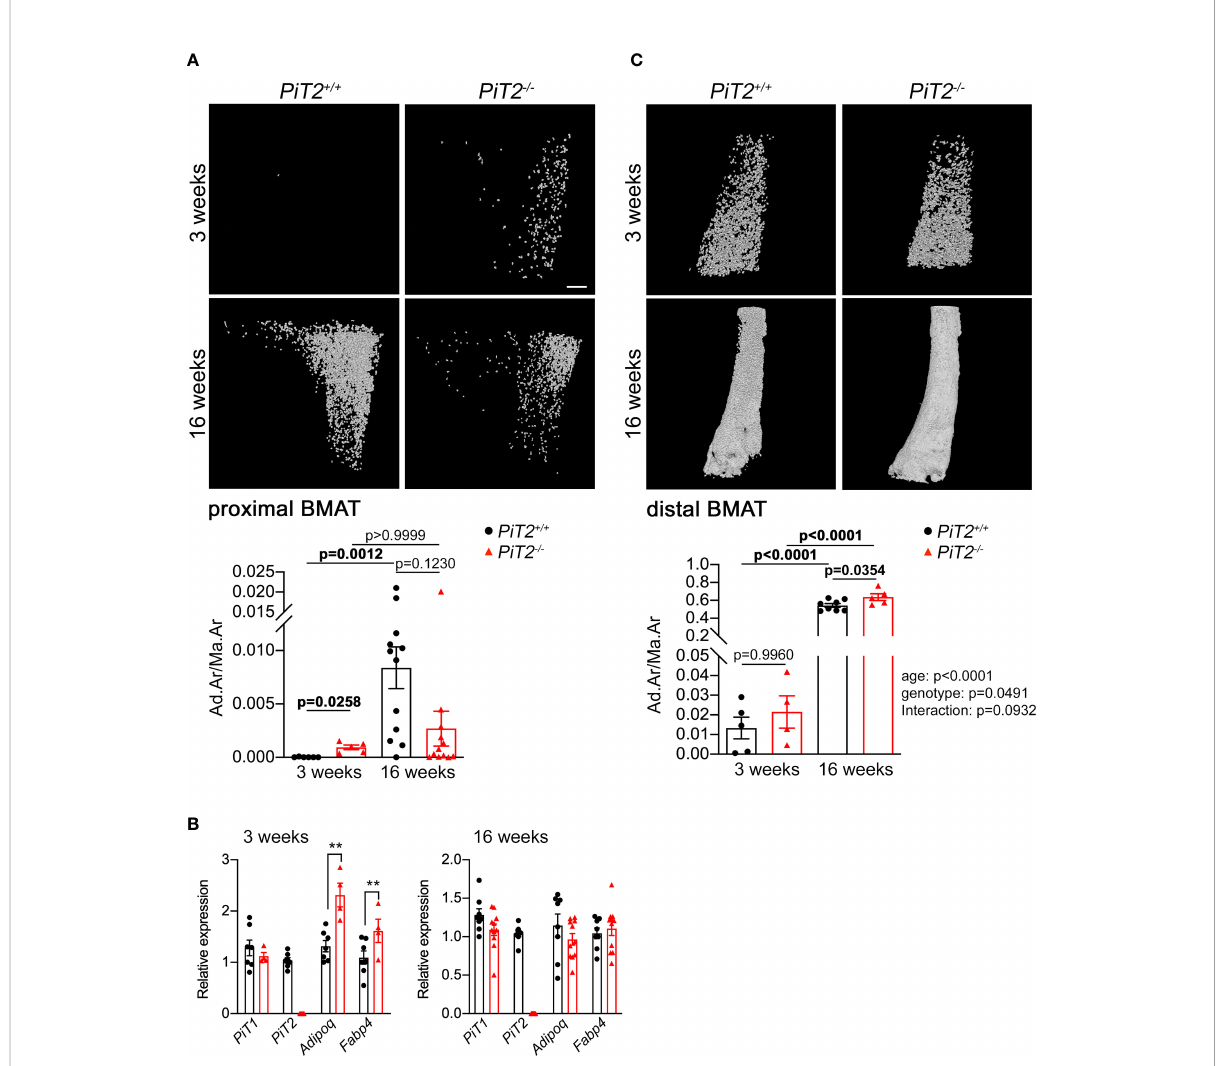
FIGURE 1 Deregulation of BMAT volume in PiT2 -/- female mice. (A) Upper - Representative 3D visualization, using Hf-POM-based CE-CT, of the adipocytes in the bone marrow compartment of the proximal tibia of 3- and 16-week-old PiT2 +/+ and PiT2 -/- female mice. Scale bar = 250 m m. Lower - Graphs showing quanti fi cation of the volume fraction of the adipocytes in the VOI of the proximal tibia (Ad.Ar/Ma.Ar: Adipocyte area/Marrow Area) of 3- and 16-week-old PiT2 +/+ and PiT2 -/- mice (n=6 and 12 per genotype, respectively). Data are means ± SEM, Bonferroni-corrected Mann-Whitney test. p values are indicated. (B) Relative PiT1 , PiT2 , Adiponectin and FABP4 mRNA expression in the whole tibia from 3- (n=7 PiT2 +/+ and n=4-6 PiT2 -/- ) and 16- (n=8 PiT2 +/+ and n=11 PiT2 -/- ) week-old PiT2 +/+ and PiT2 -/- female mice, as indicated. Data are means ± SEM, Mann-Whitney test, ** p<0.01 . (C) Upper - Representative 3D visualization of the adipocytes in the bone marrow compartment of the distal tibia of 3- and 16-week-old PiT2 +/+ and PiT2 -/- female mice. Lower - Graphs showing quanti fi cation of the volume fraction of the adipocytes in the VOI of the distal tibia of 3- and 16-week-old PiT2 +/+ and PiT2 -/- mice (n=6 and 11 per genotype, respectively). Data are means ± SEM, the in fl uence of age or genotype, and interactions between these, was determined by two-way ANOVA, with p values shown to the right of the graph. p values from multiple comparisons are indicated on the